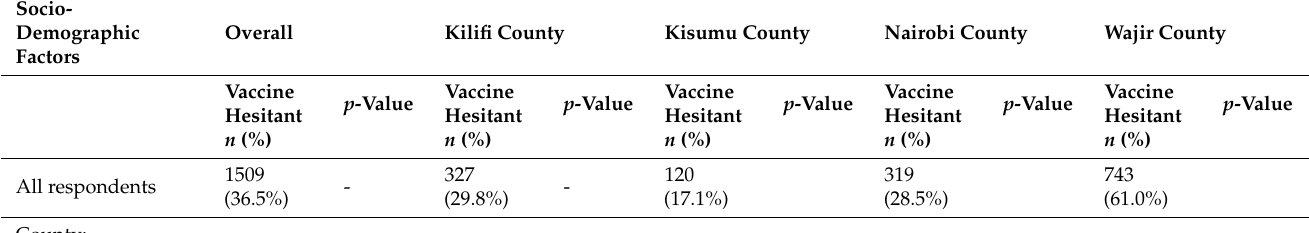
Table 3. Bivariate associations between socio-demographic factors and intent of COVID-19 vaccine uptake among respon- dents in study